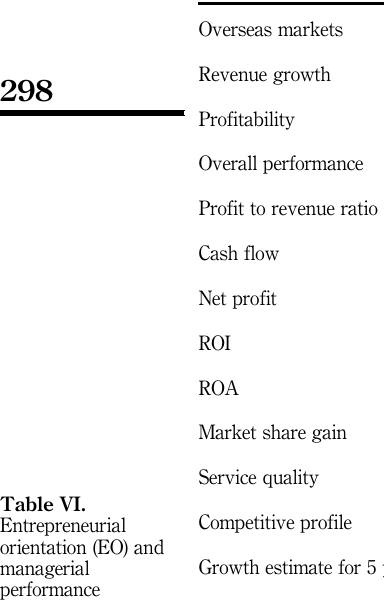
Table VI. Entrepreneurial orientation (EO) and managerial